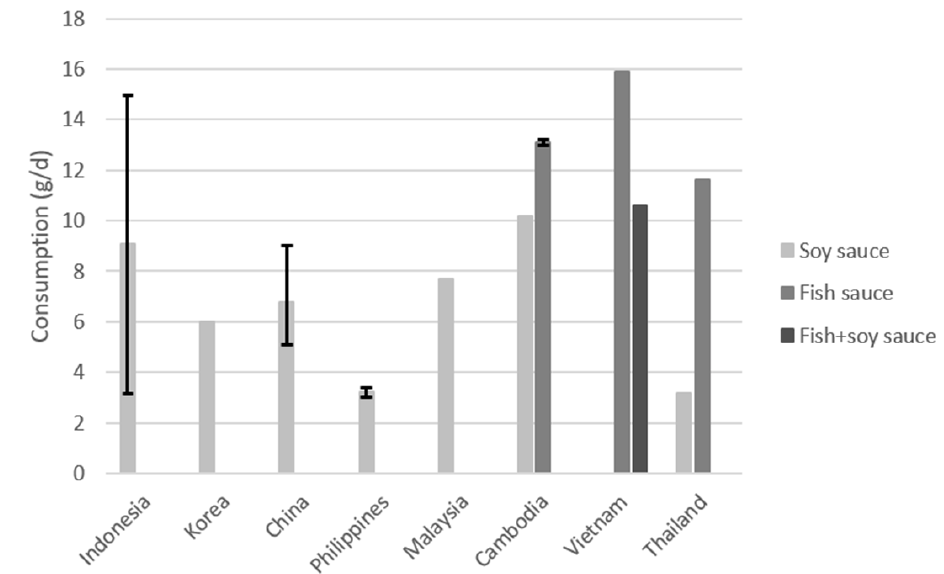
Figure 2. Average consumption of soy and fish sauce in g/day. The error bars represent the highest and lowest value found for the country.